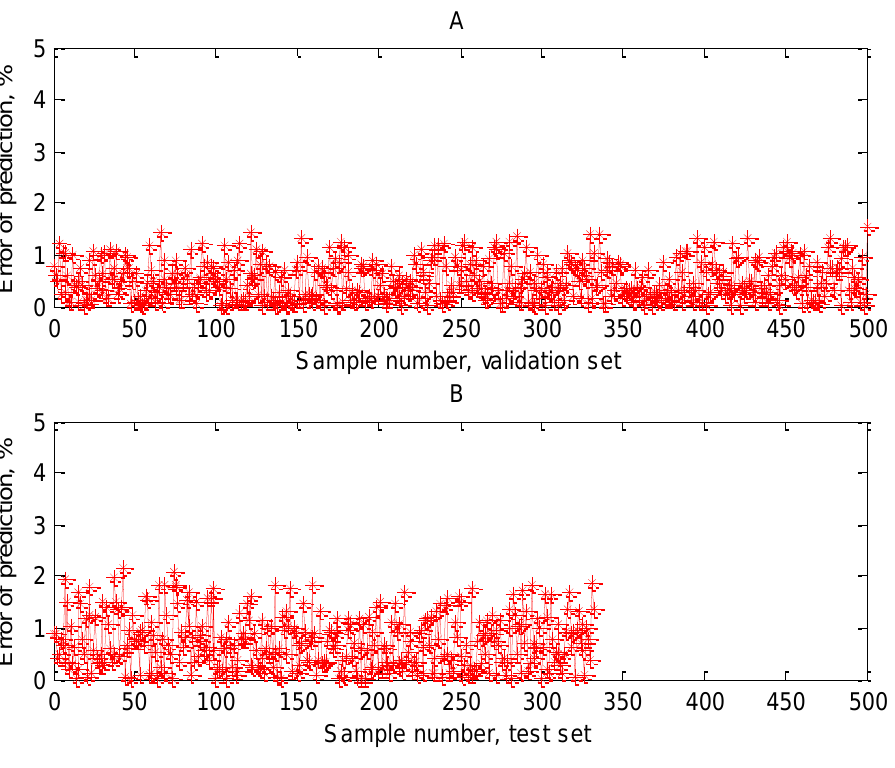
Fig. 5 Error of prediction. A. training set, 500 frozen samples; B. Test set, 332 frozen